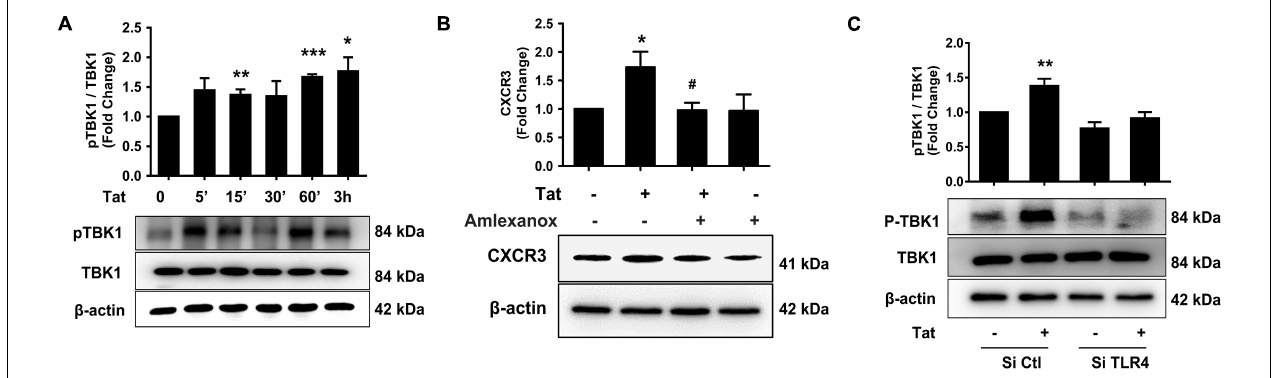
FIGURE 4 | Involvement of pTBK1 in HIV Tat-mediated upregulation of CXCR3 expression. (A) Representative Western blot and quantification of pTBK1, TBK1 in the cell lysates from human monocytes exposed to HIV Tat for various time points (5 min – 3 h). N = 4. (B) Representative Western blot and quantification of CXCR3 in the cell lysates from human monocytes pretreated with TBK1 inhibitor Amlexanox (2 µ M), followed by HIV Tat exposure for 24 h. N = 4. (C) Representative Western blot and quantification of pTBK1, TBK1 in the cell lysates from human monocytes transfected with TLR4 siRNA and nonsense siRNA transfected controls (si-Con) followed by HIV Tat exposure. N = 3. One-way ANOVA with post hoc test. All data are presented as mean ± SD of three or four individual experiments (Biological replicates). * p < 0.05 versus control group; ** p < 0.01 versus control group; *** p < 0.001 versus control group; # p < 0.05 versus HIV Tat